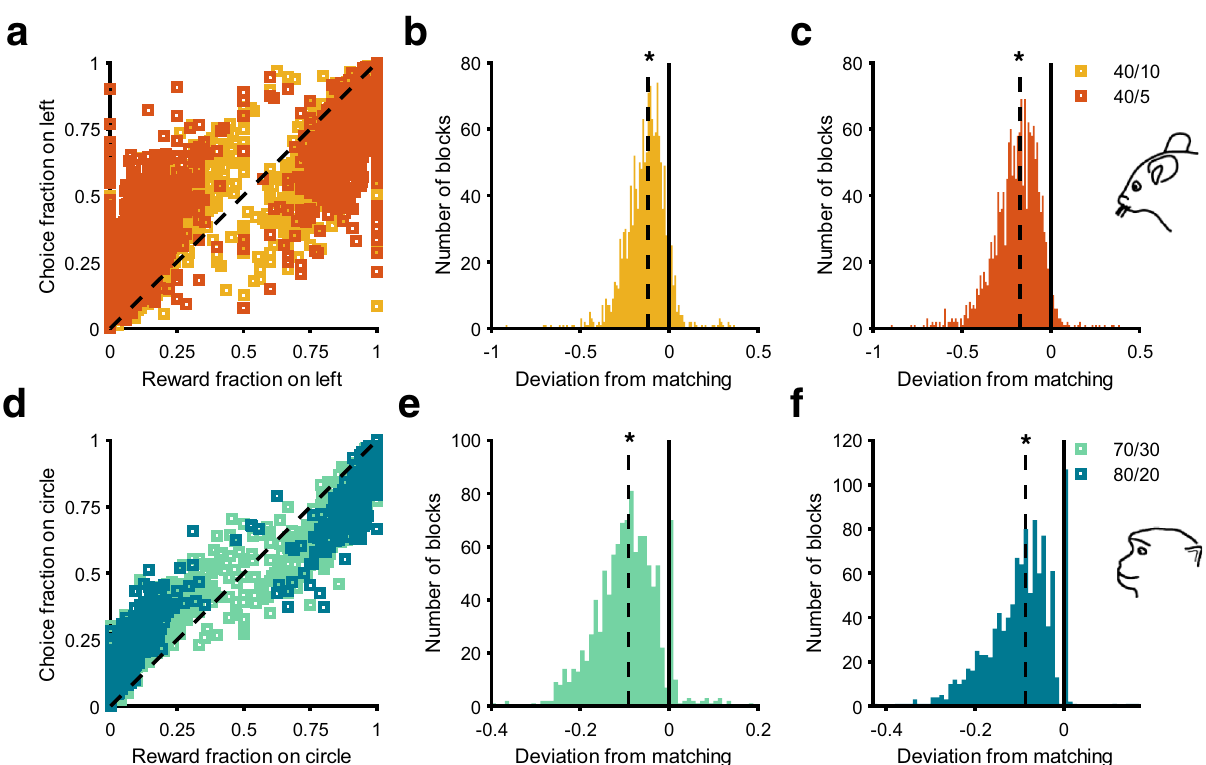
Fig. 2 Mice and monkeys exhibit highly variable but signi fi cant undermatching. a Plot shows relative reward fraction versus relative choice fraction across all blocks separately for each reward schedule in mice. The black dashed line represents the identity line. For relative reward fractions >0.5, nearly all points remain below the identity line, indicating a relative choice fraction smaller than reward fraction for the better option (undermatching). Similarly, points above the identity line for relative reward fractions <0.5 indicate undermatching. b , c Histograms show deviation from matching for the 40/10 ( b ) and 40/5 reward schedules ( c ) in mice. The solid black line indicates 0, corresponding to perfect matching. The dashed black lines are the median deviation from matching. Asterisks indicate signi fi cance based on a two-sided Wilcoxon signed-rank test ð 40 = 10 : p ¼ 1 : 53 ´ 10 (cid:2) 213 ;40 = 5: p ¼ 8 : 75 ´ 10 (cid:2) 269 Þ . d – f Similar to ( a – c ), but for monkeys with 70/30 and 80/20 reward schedules. Asterisks indicate signi fi cance based on a two-sided Wilcoxon signed-rank test ð 70 = 30: p ¼ 9 : 74 ´ 10 (cid:2) 161 ;80 = 20 : p ¼ 3 : 06 ´ 10 (cid:2) 161 Þ . Because of random fl uctuations in local reward probabilities, overmatching occurred in a minority of